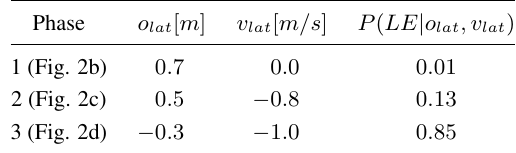
Table 6: Example for the resulting probability of LE during a lane change maneuver.